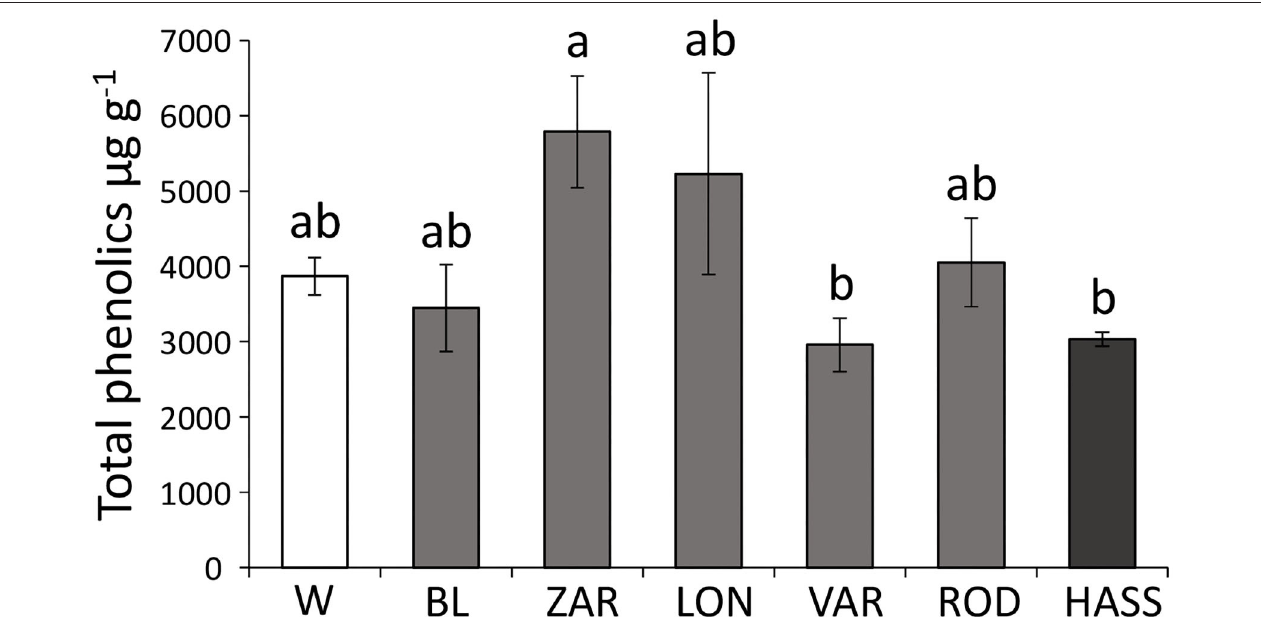
FIGURE 3 | Amounts of total phenolics in avocado ( Persea americana ) leaves by genotype across a domestication gradient. W = wild genotypes; landraces: BL = “Blanco,” LON = “Lonjas,” ZAR = “Zarcoli,” VAR = “Vargas,” and ROD = “Rodolfo.” Bars are means ( µ g/g) ± SE. Different letters indicate significant differences among genotypes ( P ≤ 0.05), according to Tukey’s HSD post-hoc test.